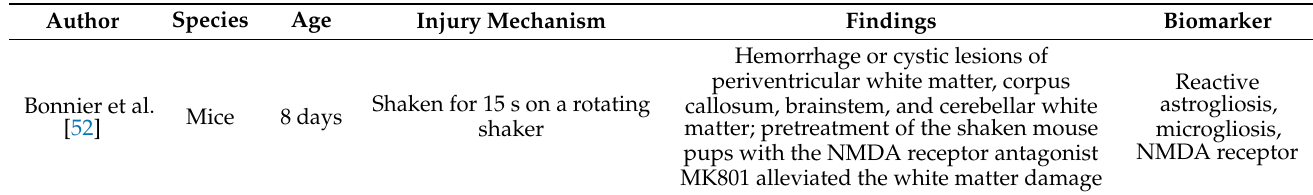
Table 2. Findings of preclinical AHT animal models and related